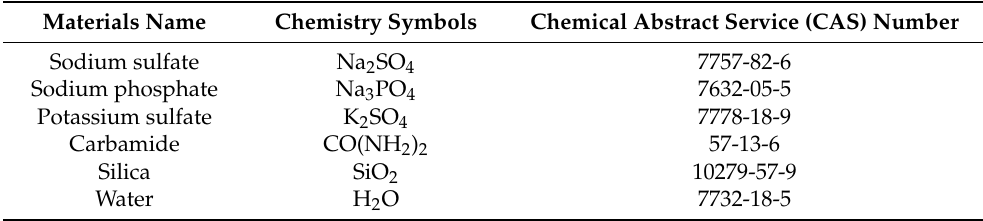
Table 1. List of chemical compositions used to fabricating the PCM.